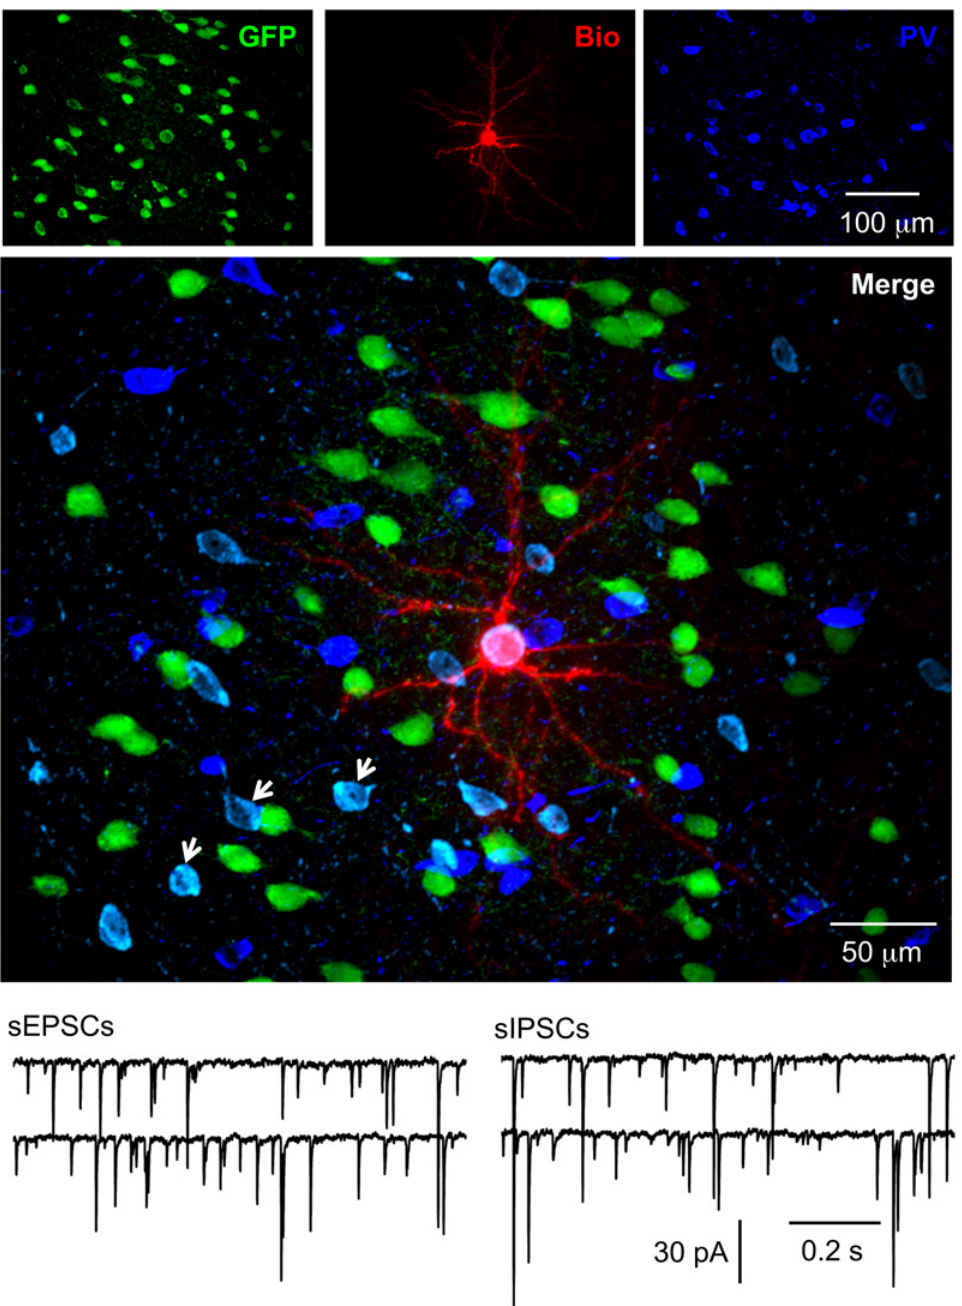
Fig 2. Functionally integrated PV-ir hNPCs. The representative hNPC was recorded in the whole-cell configuration. After recording, the slice was fixed and further processed for PV staining. The electrophysiologically identified hNPC proved to be a PV-ir interneuron. Spontaneous IPSCs, as shown in this figure, were observed in this neuron in the presence of NBQX and d-AP5, and after 20 min washout, sEPSCs were observed in the presence of PIC (not shown). To exclude the possible complications of the addition of antagonists, representative traces for spontaneous EPSCs from another PV-ir hNPC were shown in the figure in the presence of PIC. Series images from each section with GFP+ hNPCs and biocytin staining were acquired with a z-step of 0.5 μ m and stacked along the Z-axis. In the merged image, the neuron in white (GFP+Biocytin+PV) was a grafted hNPC that was recorded in whole cell mode and stained with PV; neurons in cyan (GFP+PV) were PV-ir hNPCs that were not recorded (arrows); neurons in green (GFP) were PV negative hNPCs; neurons in blue (PV) were PV-ir interneurons that were from host mouse cells. Note that anti-PV reacted with both human and mouse neurons; however, mouse PV-ir interneurons were all GFP